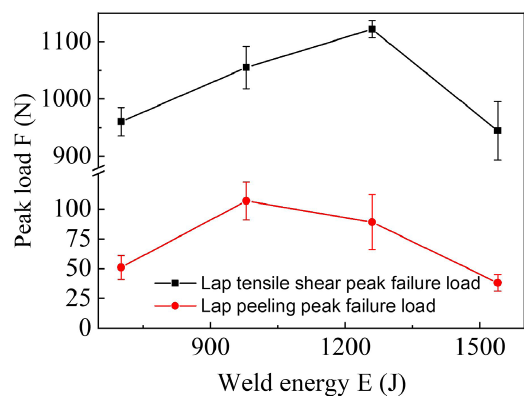
Figure 9. Lap tensile shear and peeling peak failure load test results for welded